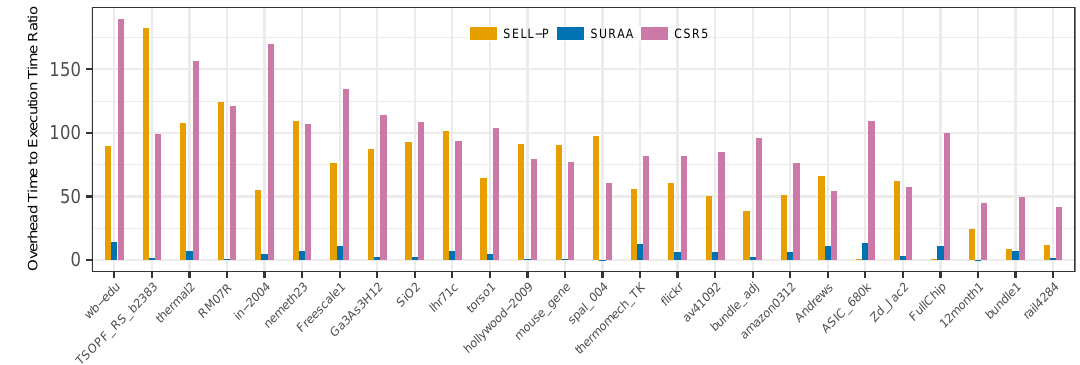
Figure 15. SURAA: A comparison of ratio of the conversion overhead time to the SpMV execution time for SELL-P, SURAA, and CSR5.